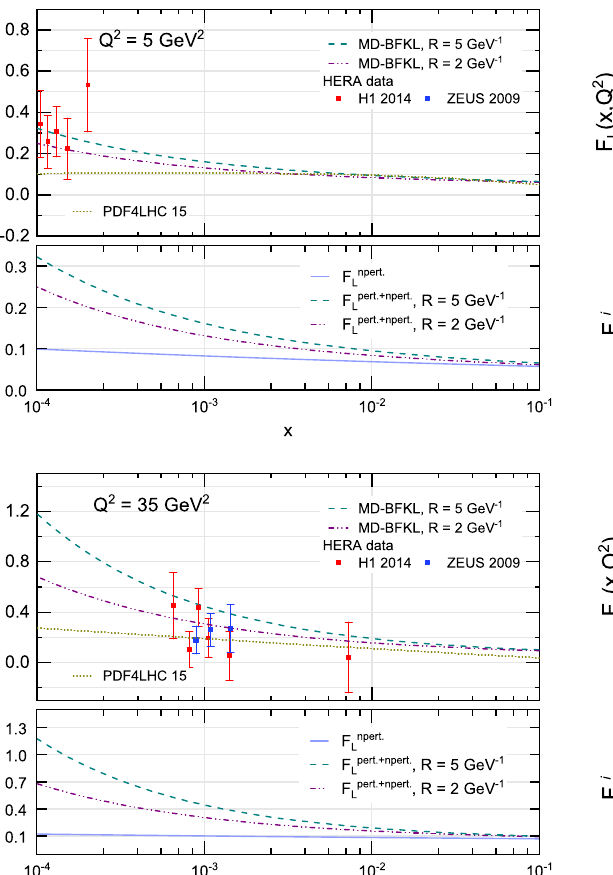
is also included. The background contribution is given by (68) with ( x = 0 . 1 ) ≈ 0 . 057, 0.063, 0.071 and 0.073 corresponding to F BG 0 L four Q 2 values viz. 5 GeV 2 , 15 GeV 2 , 35 GeV 2 and 45 GeV 2 . Sep- arate plots of F npert. vs. F npert.+pert. is also 2 2